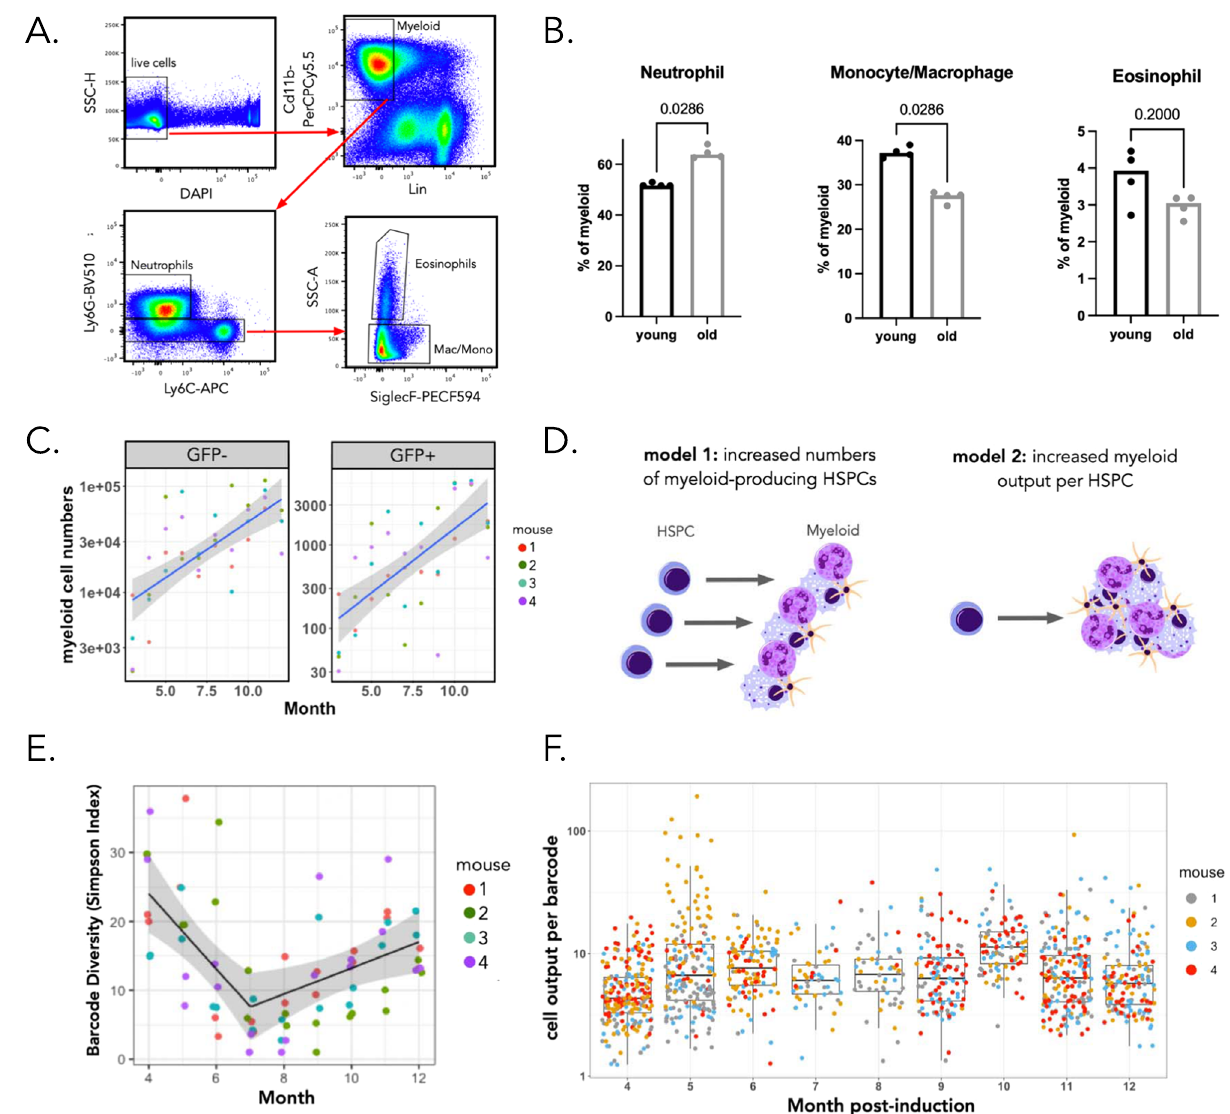
E Diversityofbarcodesinbloodbetweenmonths4and12usingtheSimpsonindex. Each sample was analyzed in duplicate. The black line represents the mean Simp- son ’ s index estimate, obtained from the fi tted gamma generalized linear mixed model with a breakpoint; the gray ribbon represents the 95% CI for the true mean. n =4adultmaleDRAGmice. F Numberofmyeloidcellsproducedperbarcode(i.e., clone size) over time post-induction. Pooled data of four mice, with each color representing a different mouse, are depicted. The boxplot represents the median and interquartile range. The whiskers extend to 1.5 times the interquartile range values. Source data are provided as a Source Data fi le, while larger datasets and associated source code are available at: https://github.com/TeamPerie/